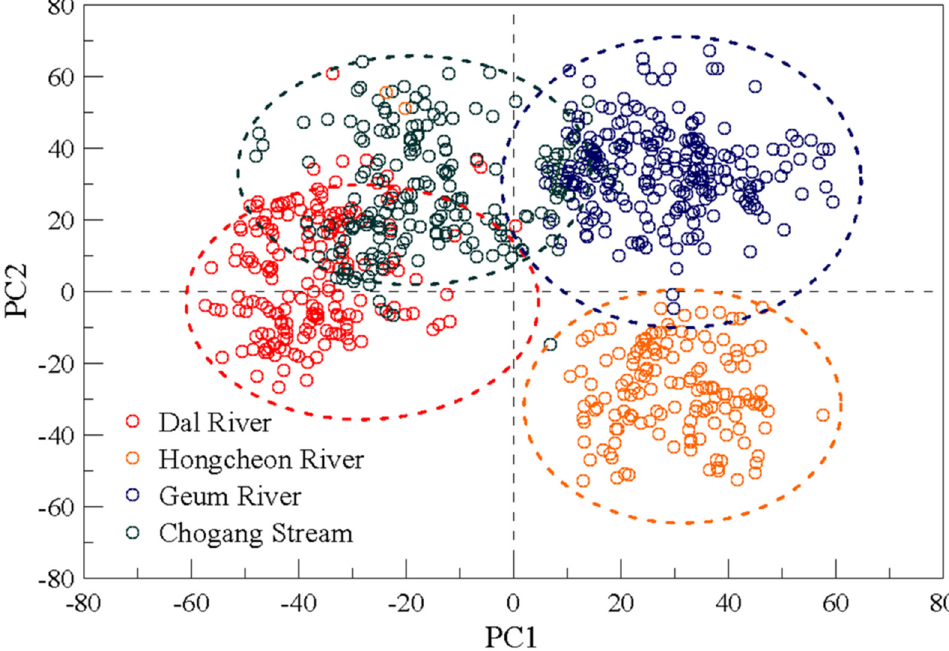
Figure 4. Result of a principal component